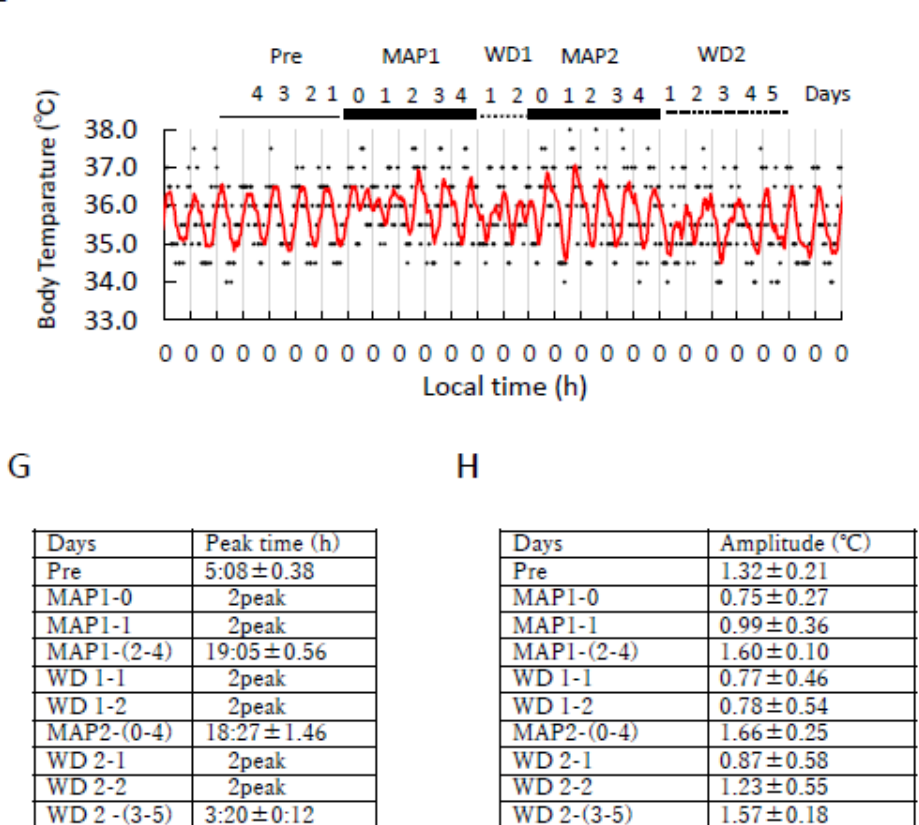
Figure 1. Effect of daily MAP injections on locomotor activity and body temperature rhythm. ( A ) Schematic figure of MAP intraperitoneal (i.p.) injection schedule at ZT3. ( B ) Anticipatory locomotor activity. Representative double-plotted actographs of the Per1-luc mice subjected to MAP are shown. The red line in the vertical bar indicates the time of injection (MAP1 0–4, MAP2 0–4) at ZT3 (AM11:00). Levels of behavioral activity are indicated by black columns. The figure depicts locomotor activity beginning prior to the start of injections. MAP injection resulted in an acute increase in locomotor activity, with anticipatory activity prior to the scheduled injection, and an increase in activity following injection. Red boxes indicate anticipatory activity without MAP injections. The horizontal bar at the top of each panel represents the light cycle—the light phase with open bars and the dark phase with filled bars. ( C ) The amount of locomotor activity during the day and night. After MAP injection, the amount of locomotor activity during the day and night was reversed. “Pre” indicates before MAP injection. Day 0 indicates the start day of MAP injection. Open and closed columns show day (08:00–20:00) and night (20:00–08:00), respectively. Statistical significance was determined by one-way ANOVA followed by Dunnett’s test ( n = 4 animals) (** p < 0.01, *** p < 0.001 vs. Pre Day). ( D ) Amount of locomotor activity between 9:00 and 11:00 at Pre, MAP1 0–4, WD1–1, and WD1–2. MAP was withdrawn at WD1–1 and WD1–2 after daily MAP injection at ZT3 (11:00) for 5 days (MAP1 0–4). Vertical values show the anticipatory activity (%) {[(activity counts from 2 h)/(activity counts for a full day)] × 100} on the day before or after MAP. Statistical significance was determined by one-way ANOVA followed by Dunnett’s test ( n = 4 animals) (** p < 0.01, *** p < 0.001 vs. Pre 1–4). ( E ) Anticipatory activity persisted after withdrawal. MAP was withdrawn after daily MAP injection at ZT3 (11:00) (MAP2 0–4). Day 1 indicates the day after withdrawing MAP. Statistical significance was determined by two-way ANOVA followed by Bonferroni’s multiple comparisons test ( n = 4 animals) (* p < 0.05, ** p < 0.01, *** p < 0.001 vs. saline). ( F ) Body temperature rhythm of